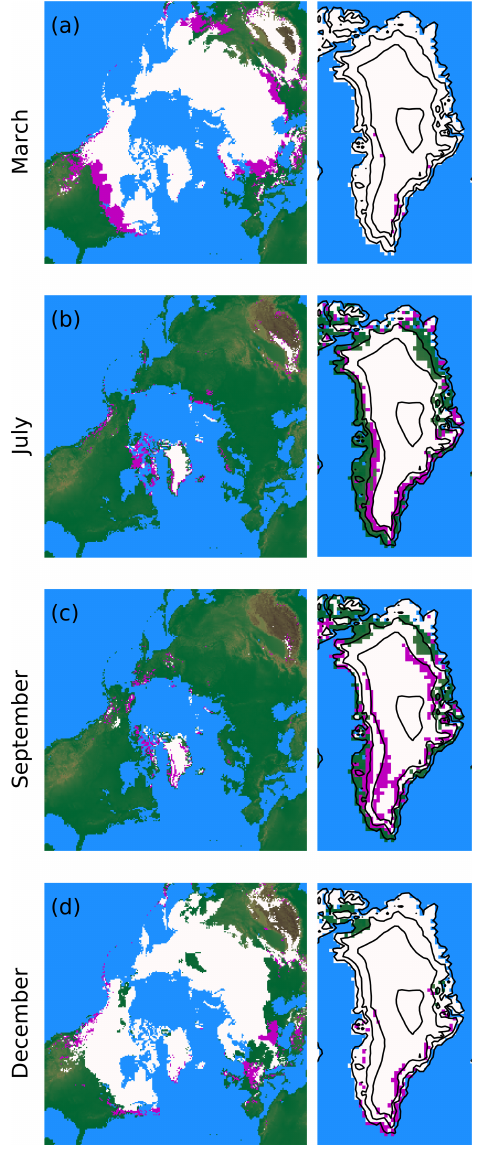
Figure 8. Seasonal snow extent for the year 2012, simulation BEST T . White areas contained at least 25kgm − 1 snow at the mid- dle of the respective month. Magenta highlights the presence of liq- uid water at any depth in the firn column. Contour levels show ele- vation with a spacing of 1000m in the right column. Meltwater in the firn does not freeze immediately at the beginning of the winter season, which leads to the two bands of liquid water in west Green- land in September. Some regions never freeze all meltwater so that liquid water is present year